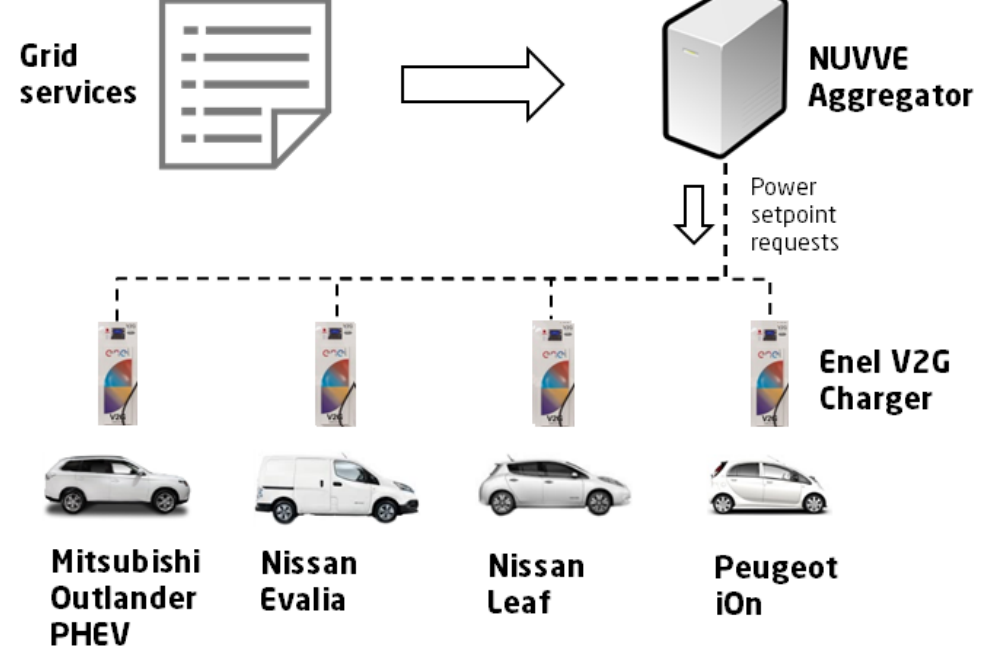
Figure 3. Parker reference configuration.